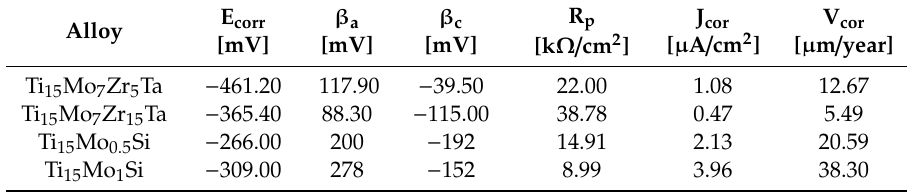
Table 3. The main parameters of the Ringer solution corrosion process.